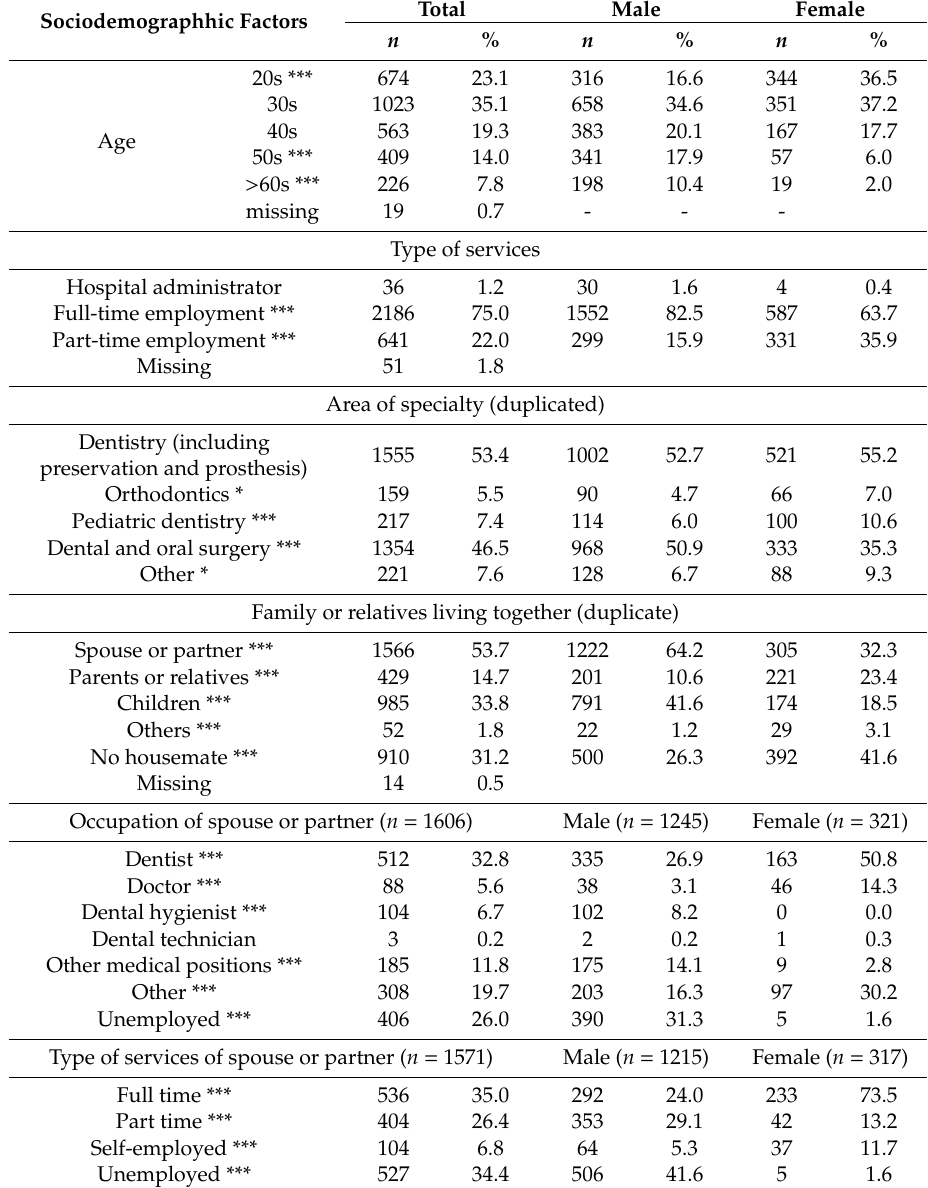
Table 1. Sociodemographics and characteristics of the hospital dentists who responded by gender ( n =